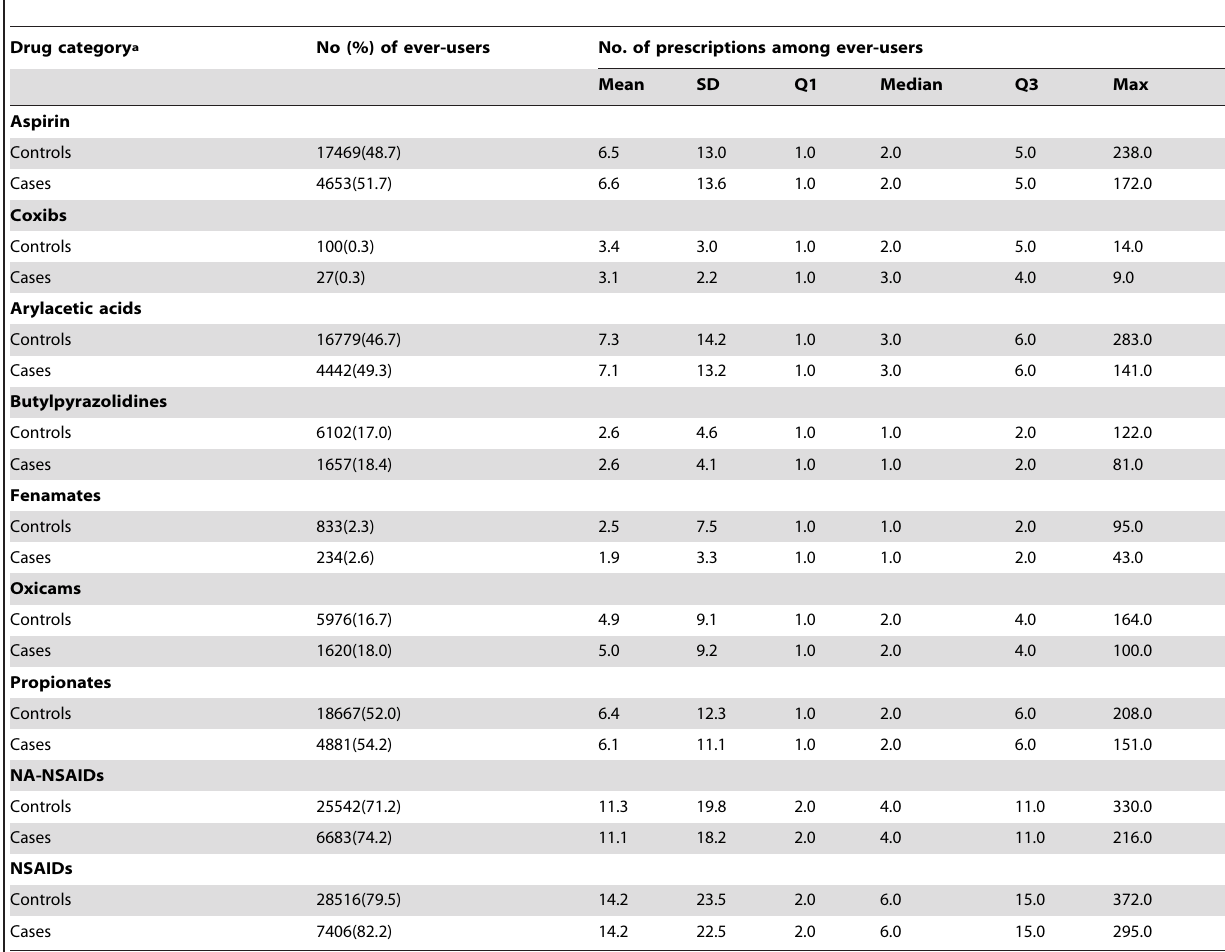
Table 2. Ever-use of NSAIDs and descriptive statistics of total number of prescriptions among ever-users by case-control status and drug